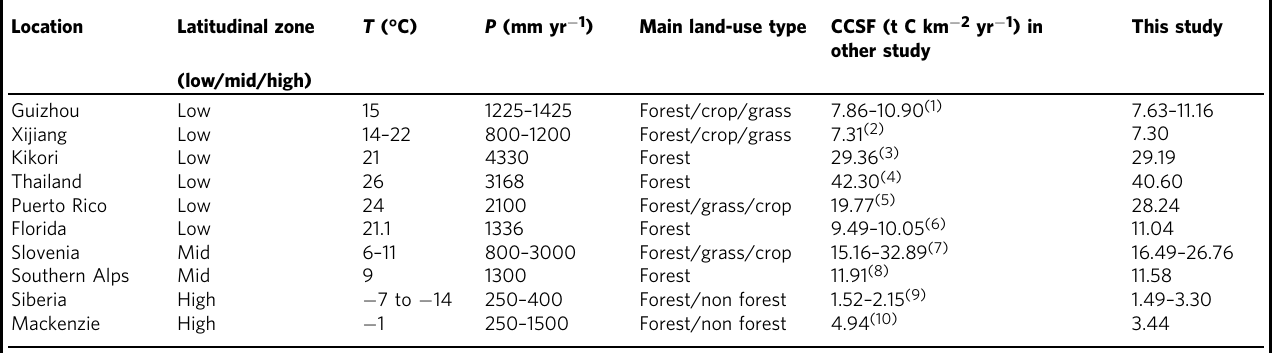
Table 1 Comparison of CCSF between our modelled results and other studies in different latitudinal zones with different climate and land-use